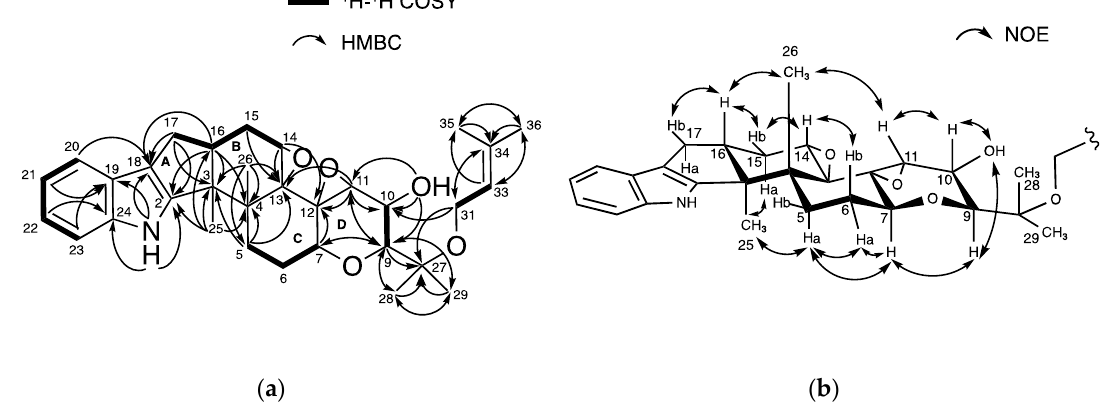
Figure 5. Structural elucidation of 3 : ( a ) Key correlations in 1 H- 1 H COSY and HMBC spectra; ( b ) NOESY experiments.